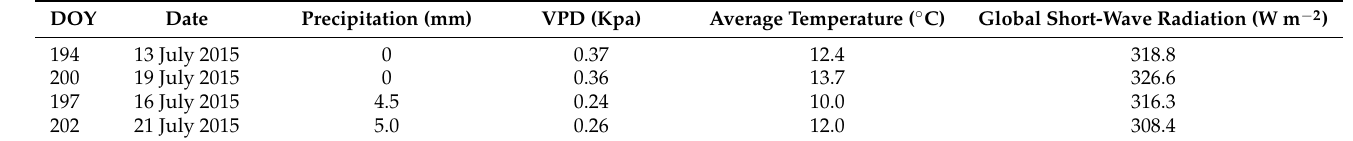
Table 4. Days selected for the comparison analysis of the treatment group and the control group.